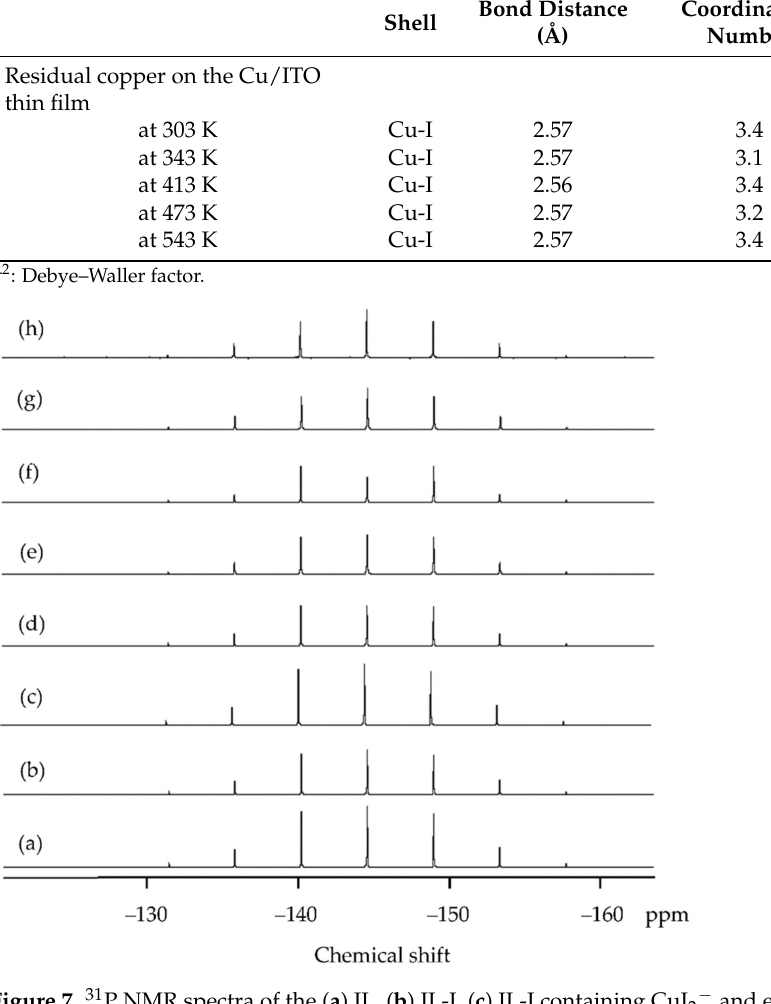
Figure 7. 31 P NMR spectra of the ( a ) IL, ( b ) IL-I, ( c ) IL-I containing CuI 2 − and extracted-copper IL-I